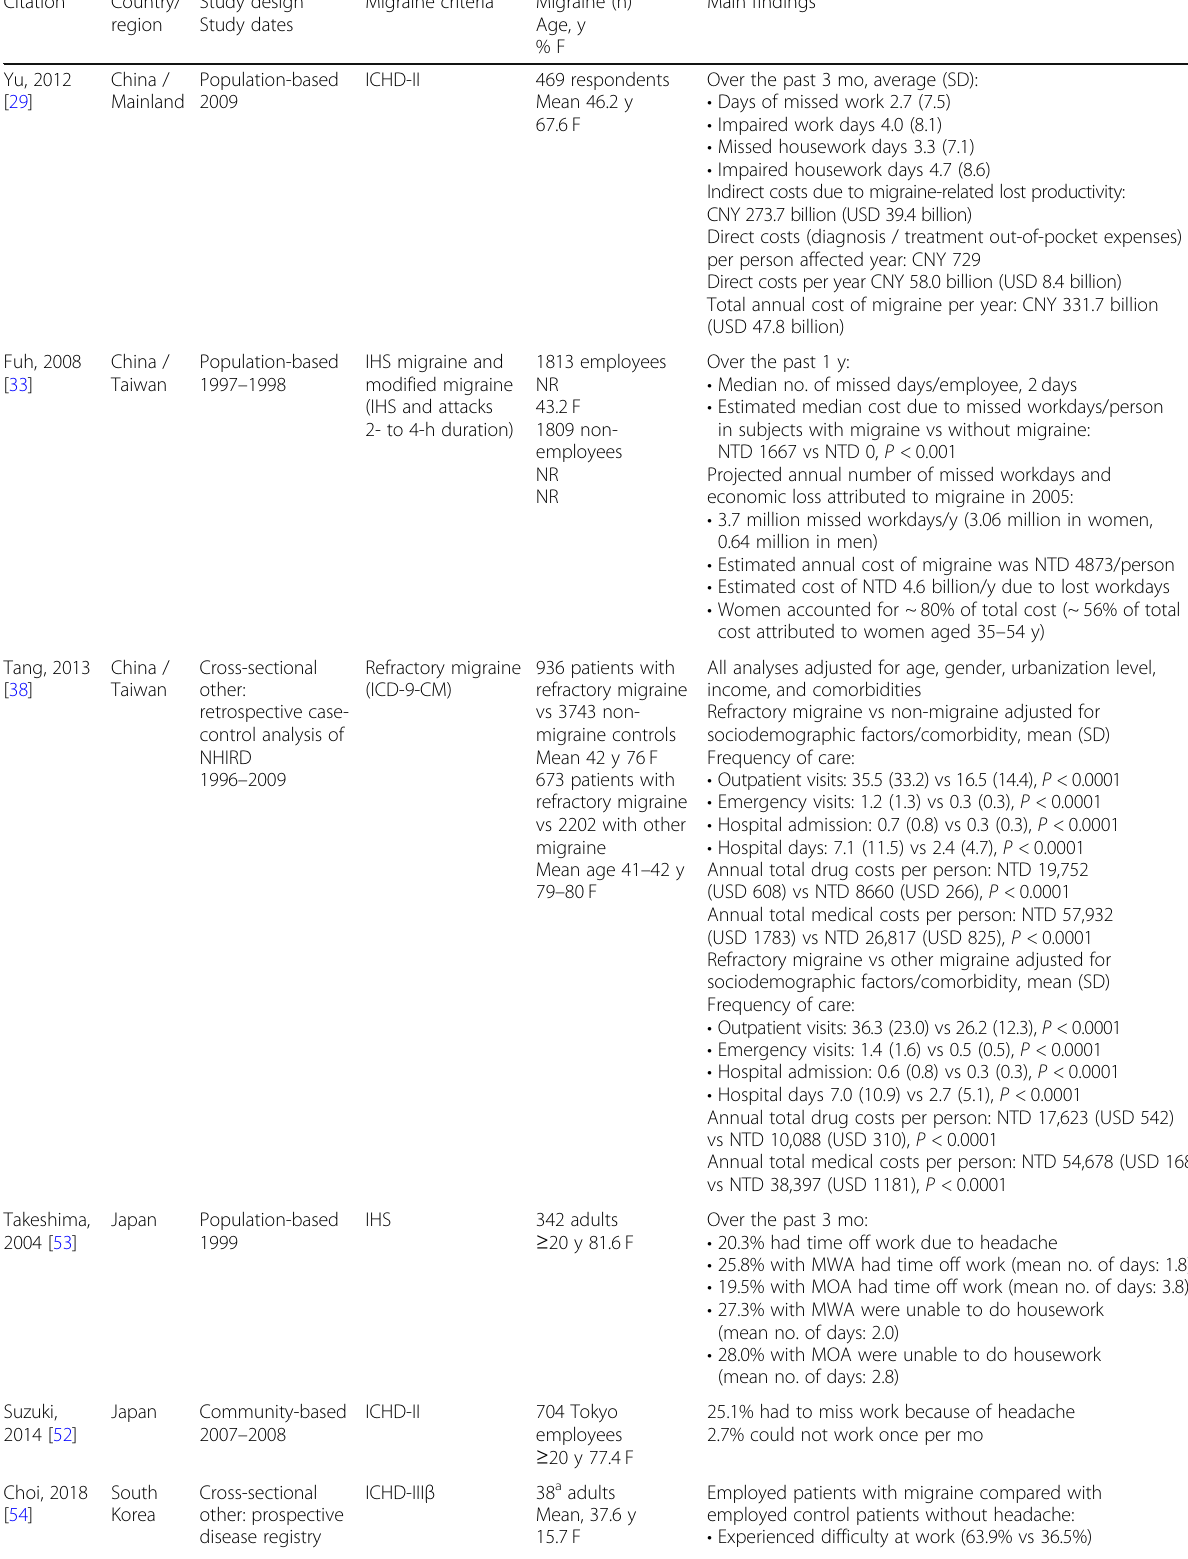
Table 2 Studies reporting economic burden of migraine